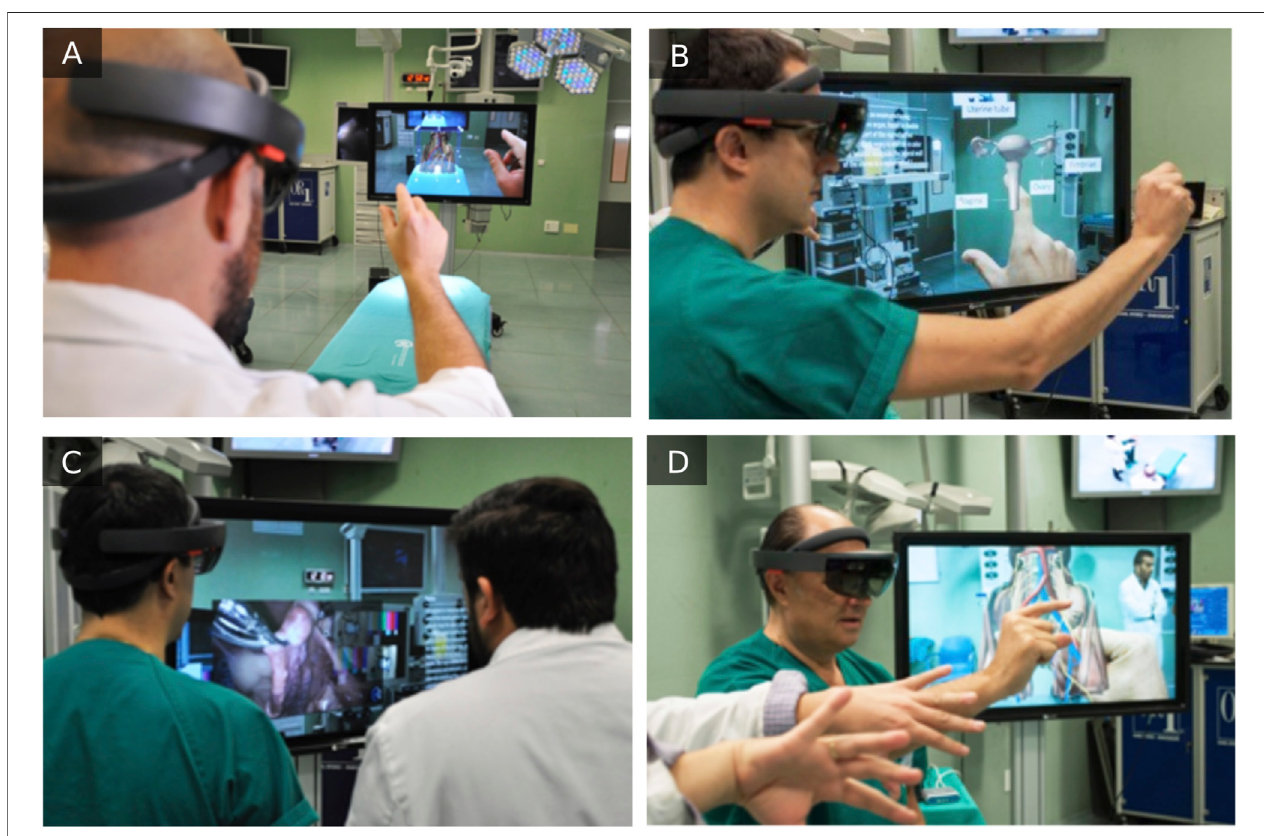
FIGURE 3 | Interaction with 3D anatomical models: the human pelvis (A,D) and uterus (B) . Visualisation of reference videos of related surgical procedures (C) .